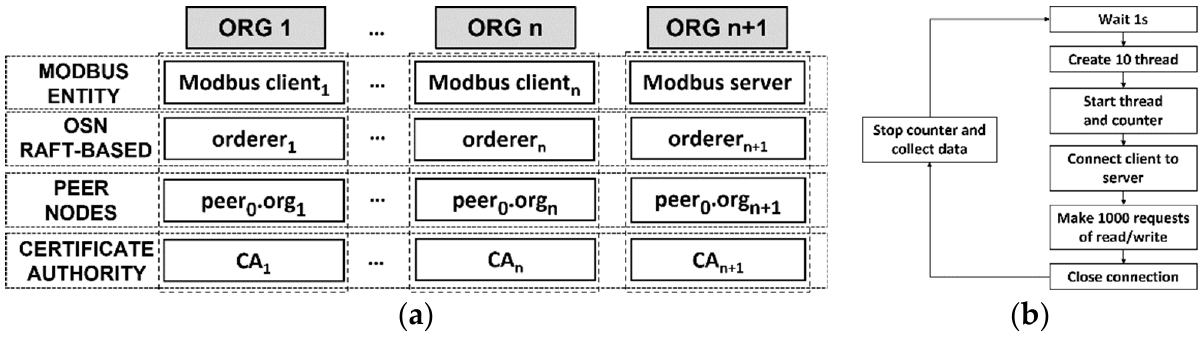
Figure 4. ( a ) Testbed applied on performance measure; ( b ) flow chart of Modbus performance test.